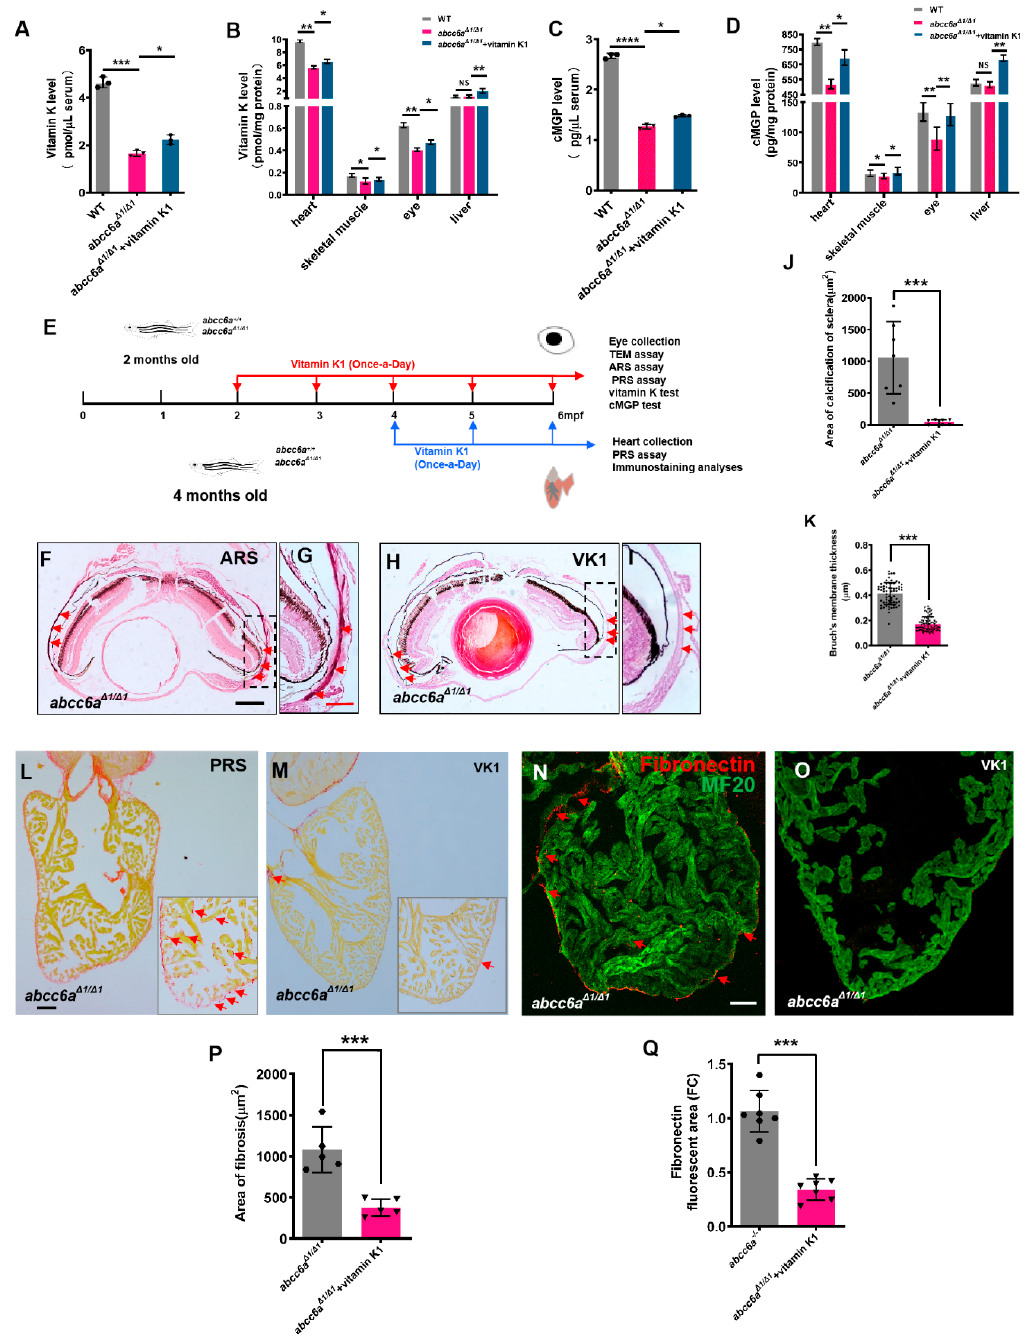
Figure 4. Vitamin K treatment relives ocular calcification and cardiac fibrosis in abcc6a Δ 1/ Δ 1 mutants. ( A – D ) Graphical representation of sandwich ELISA measurements for tissue and serum vitamin K and cMGP levels in WT (n = 18) and DMSO/ethanol- (n = 18) or vitamin K1-treated abcc6a Δ 1 / Δ 1 fish (n = 18) fish. * p < 0.05, ** p < 0.01, *** p < 0.001, **** p < 0.0001, Student’s t -test (unpaired, two-tailed). ( E ) Experimental design for once-a-day DMSO/ethanol (0.1%) and vitamin K1 (80 μ M) treatment of abcc6a +/+ and abcc6a Δ 1 / Δ 1 fish. Red arrows indicate experimental steps, changing water every day for 4 months from 2 months old; for eye collection, TEM, ARS, and PRS assay, vitamin K and cMGP tests. Blue arrows indicate experimental steps for heart collection, PRS assay and immunostaining analyses for 2 months from 4 months of age. ( F – I )